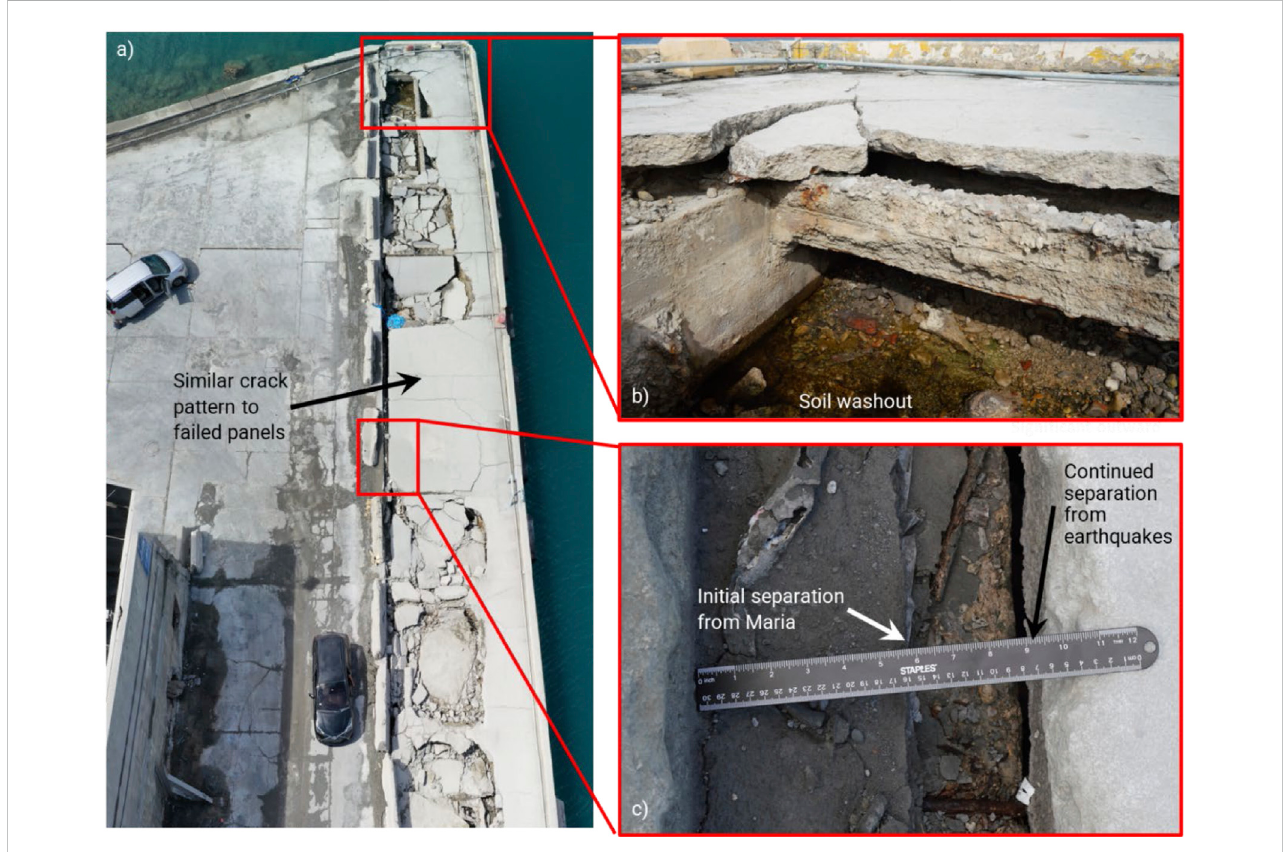
FIGURE 6 Images of damages to Pier following January 2020 earthquake series including (A) an aerial view of the overall damage, (B) washout of soil underneath collapsed panel, and (C) representative image showing separation of main slab and